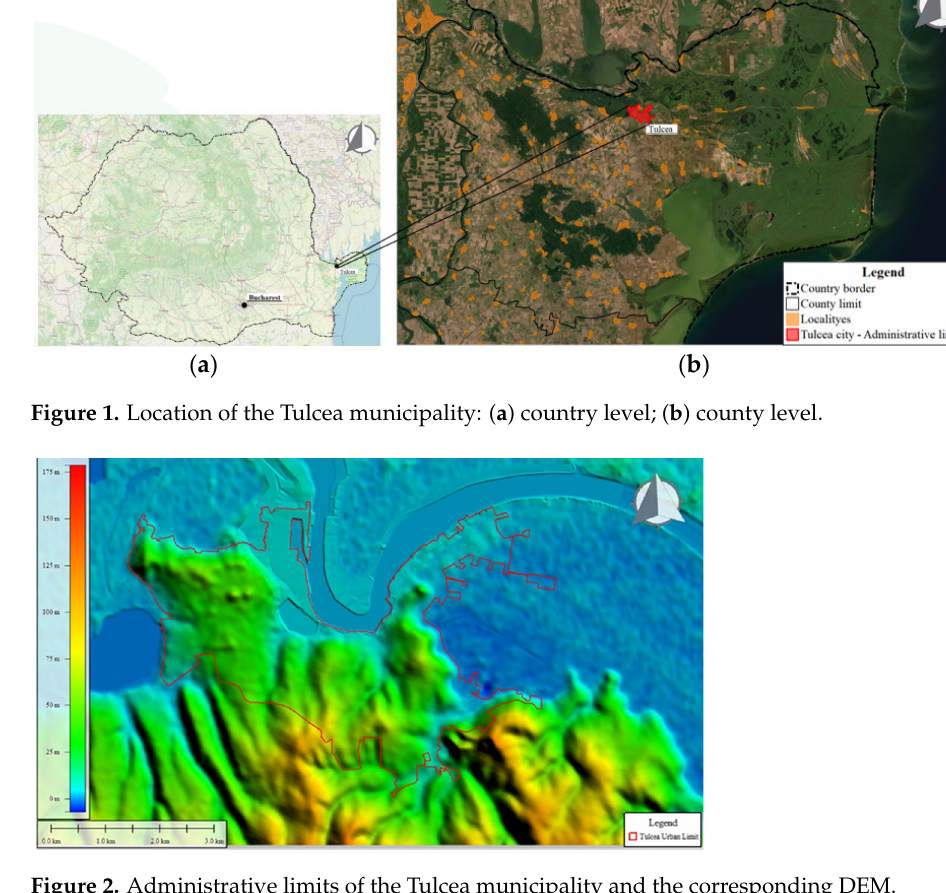
( b ) Figure 3. Flooded areas in Tulcea during the heavy rains in: ( a ) 2013—Intersection of the Isaccea street with Unirii street; ( b ) 2016—Lieutenant Gavrilov Street.